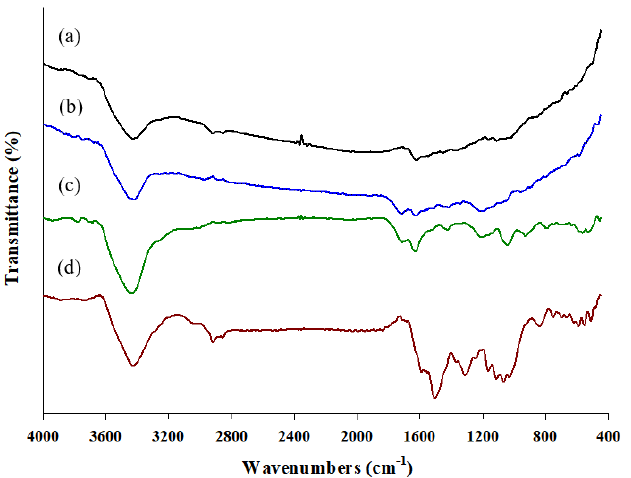
Figure 1. The FT-IR spectra of (a) pristine MWCNTs, (b) oxidized MWCNT, (c) MWCNT−IL, and (d) the MWCNT−IL/PANI composite.